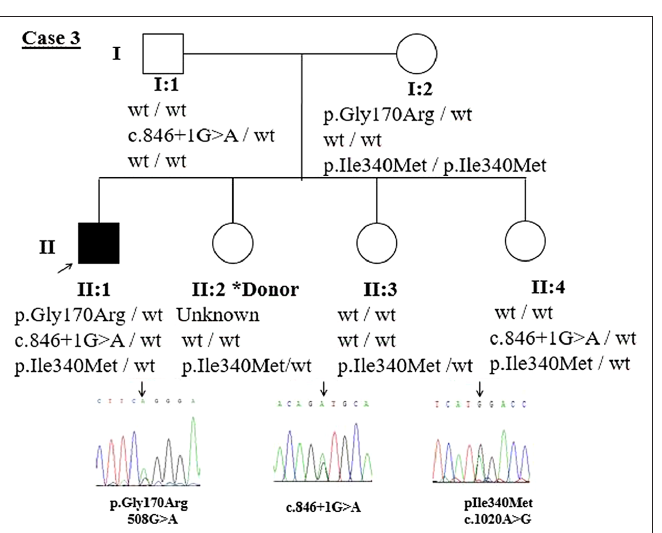
Figure 1. Sequence results of Case 1 and Case 2.